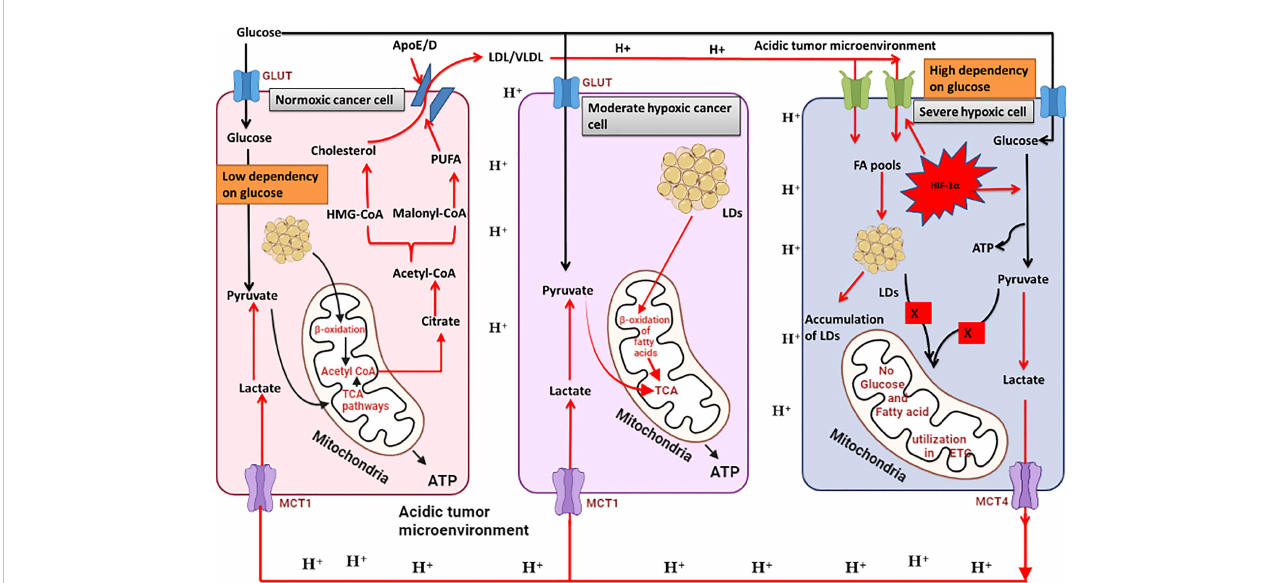
FIGURE 4 Metabolic symbiosis in cancer cells to utilize glucose and lactate for fatty acid synthesis and utilisation. Severely hypoxic cancer cells can oxidise glucose only through glycolysis which results in excessive production of lactate secreted in the tumour microenvironment. Enhanced glycolysis in these cells also results in lipid droplet accumulation. OXPHOS cancer cells can use lactate for oxidative phosphorylation by converting it back to pyruvate. Therefore, OXPHOS cells and severely hypoxic cancer cells develop a metabolic symbiosis for glucose and lactate utilisation. Excess lactate in OXPHOS cells is released as citrate which is utilised in fatty acid synthesis. Moderately hypoxic cancer cells can utilise fatty acids for ATP production through b -oxidation of fatty acids. Fatty acids accumulate in severely hypoxic cancer cells and are transported towards OXPHOS cells, where they are partly converted into fatty acids and utilised in b -oxidation for energy production. A large portion is converted into polyunsaturated fatty acids (PUFAs) which are further incorporated into plasma membrane synthesis. Created by